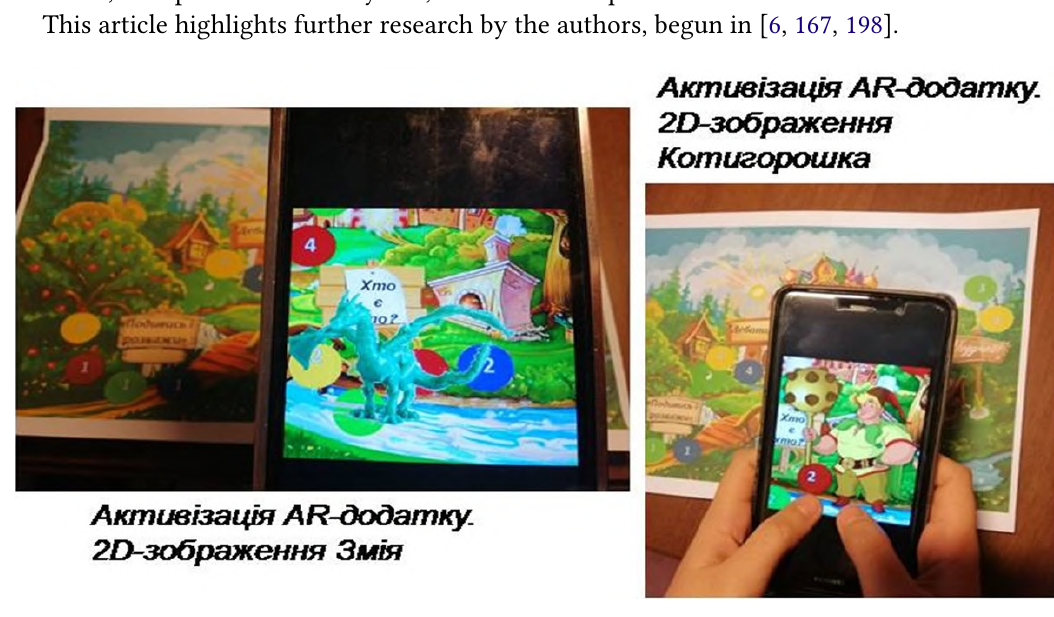
Figure 55: Presentation of paper